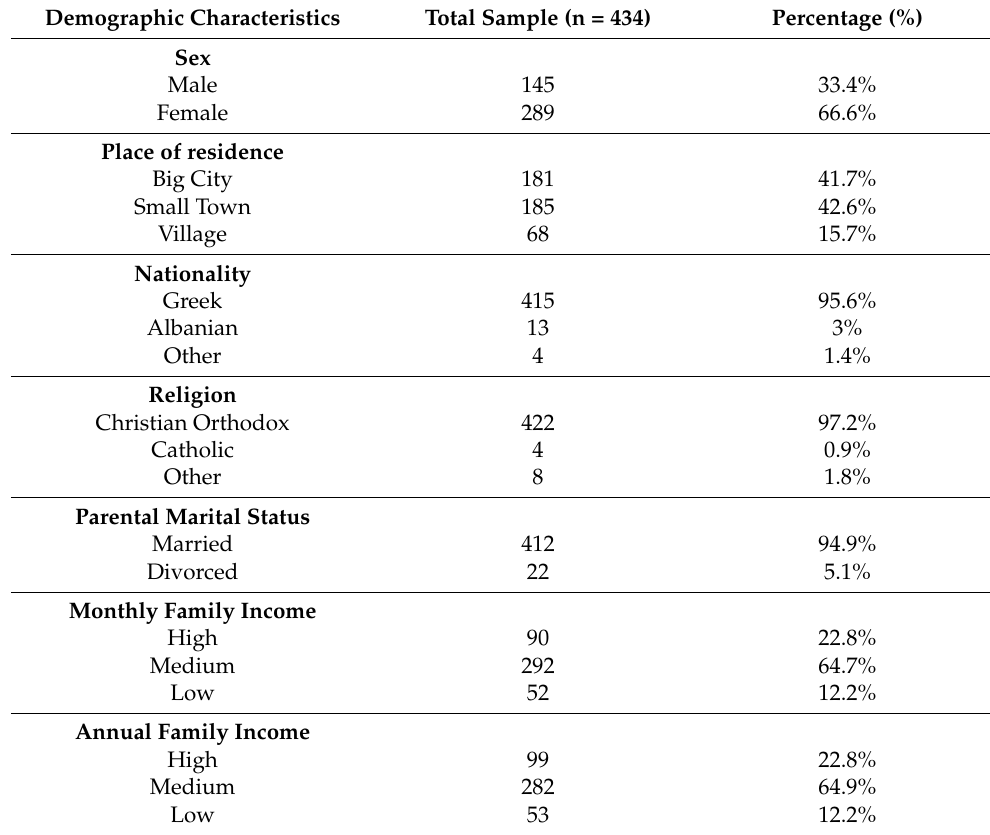
Table 2. Participants (intervention and control group) characteristics at the baseline (Phase I) (n = 434). Demographic